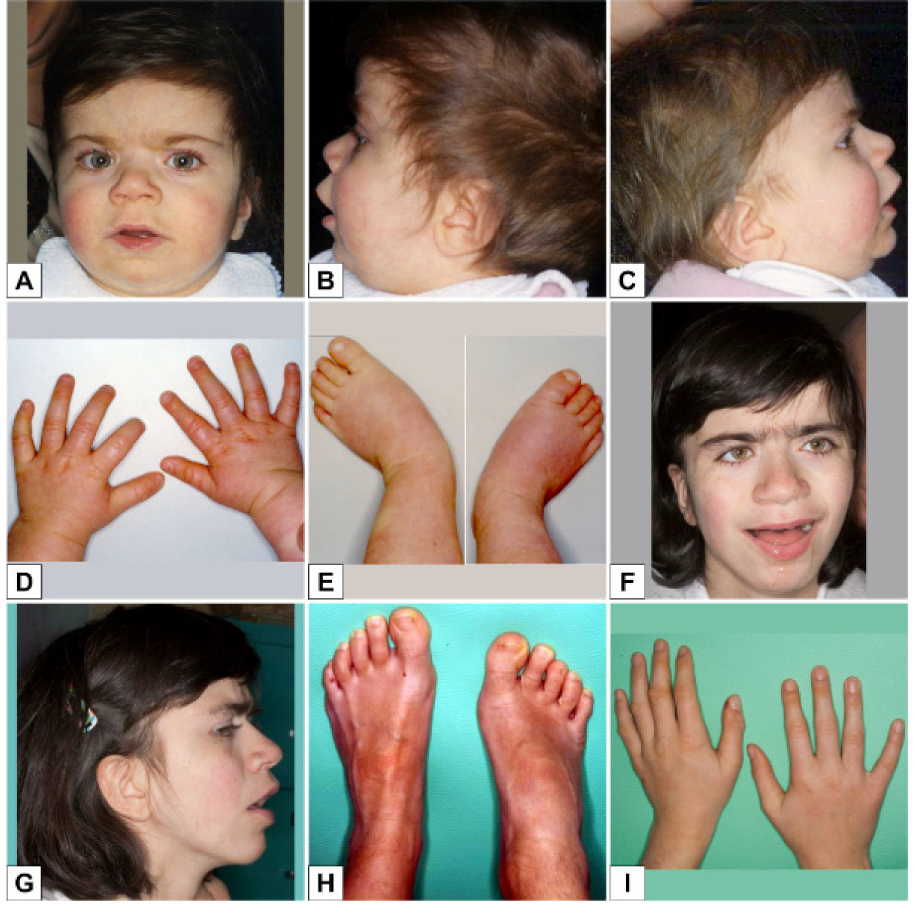
Figure 1. ( A – C ) Clinical features at the age of 1 year: mild coarse face, high-arched, thick eyebrows, long eyelashes, synophrys, broad nasal tip, anteverted nares, smooth long philtrum, thin upper lip, mild low-set ears, and hirsutism; ( D , E ) hands and feet; ( F , G ) clinical features at the age of 16 years: mild coarse face, high-arched thick eyebrows, long eyelashes, synophrys, broad nasal tip, anteverted nares, smooth long philtrum, thin upper lip, low-set ears and hirsutism; ( H , I ) hands and feet. Her psychomotor development was significantly delayed: she got into sitting position at 18 months and she reached the standing position with help at 30 months; her speech remained limited to prelinguistic vocalization. Ophthalmologic investigation revealed myopia and astigmatism; fundus oculi showed slightly pale and broad appearance of the optic disc with central colobomatous defect. Audiometry test detected conductive hearing loss; auditory brainstem response was normal. A cardiac ultrasound confirmed apical muscular VSD and showed a mild to moderate hypertrophic cardiomyopathy.